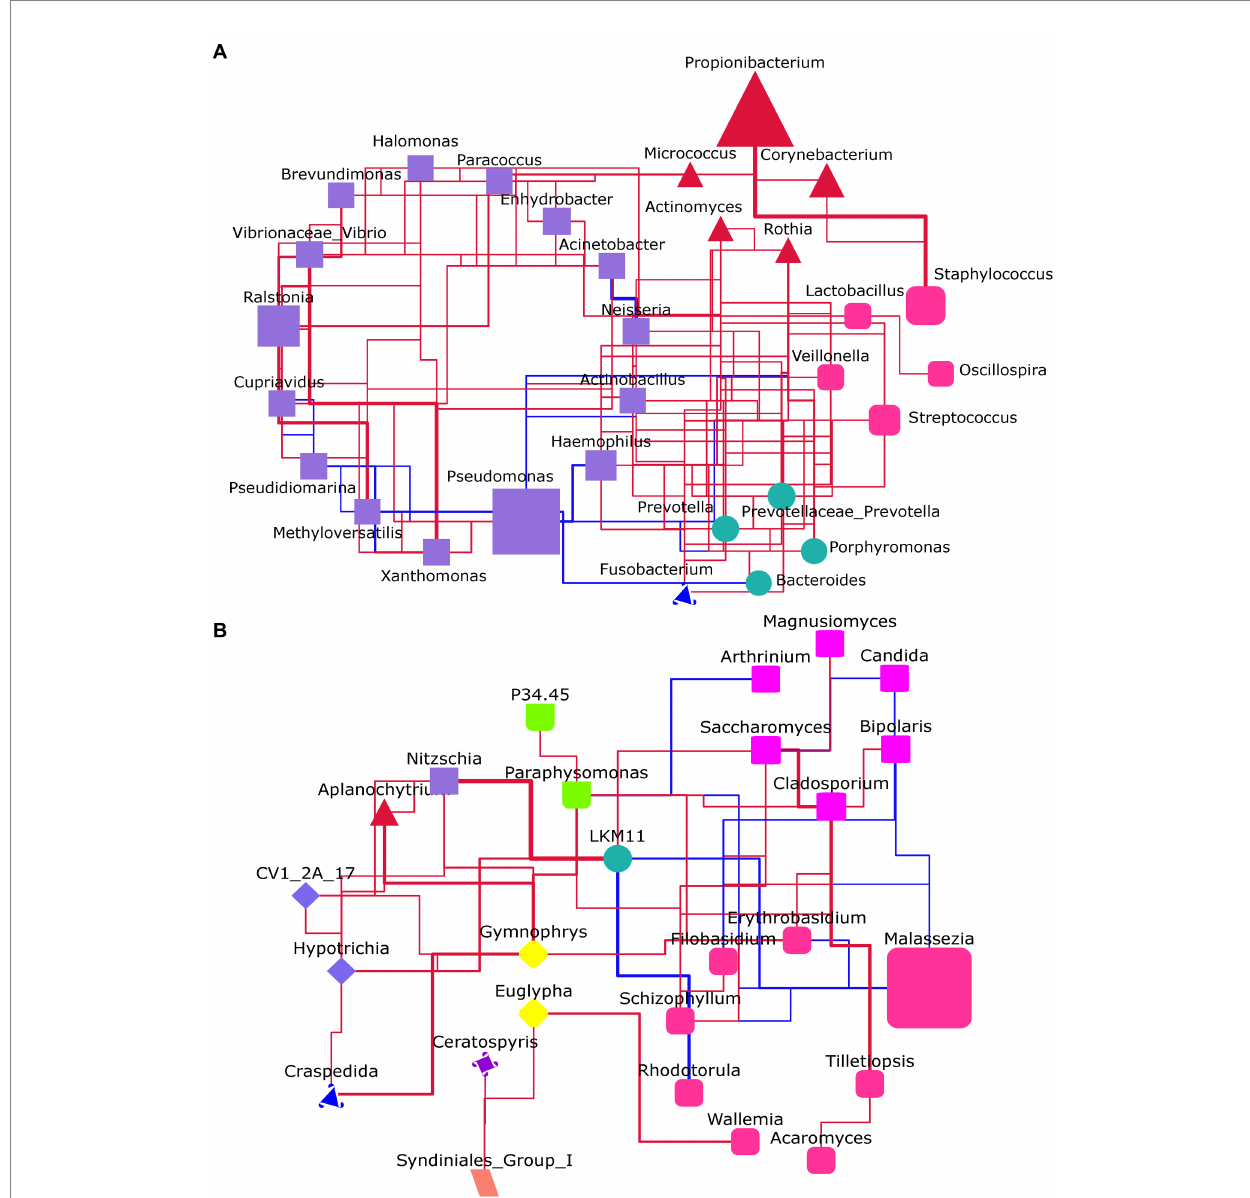
FIGURE 5 The microbial network analysis at the genus level. (A) For the bacteria flora. (B) For the fungal flora. The genera within the same phylum had the same shape and color. The size of the shape represents the abundance of genus. Red line: positive correlation; Blue line: negative correlation; The thicker the line, the stronger the